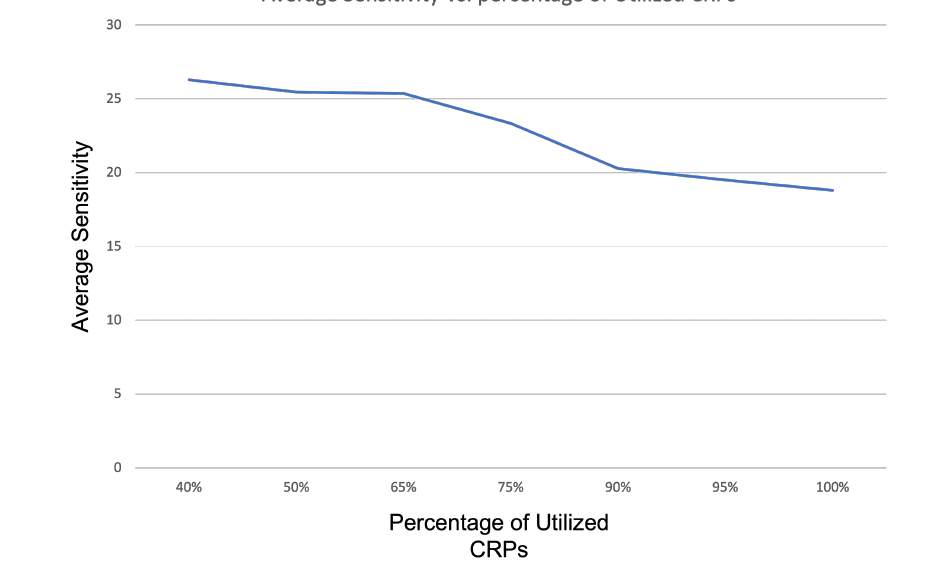
Figure 9. Average sensitivity behavior by increasing the number of